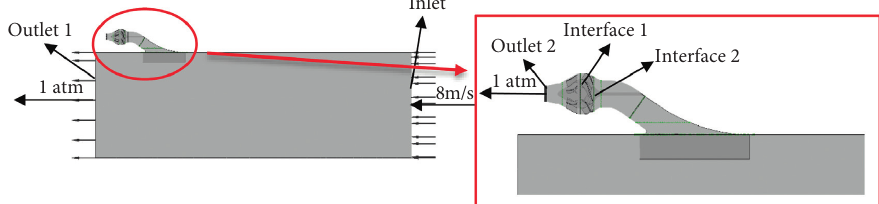
Figure 4: Schematic diagram of boundary conditions (interface 1: between impeller and guide vane; interface 2: between impeller and